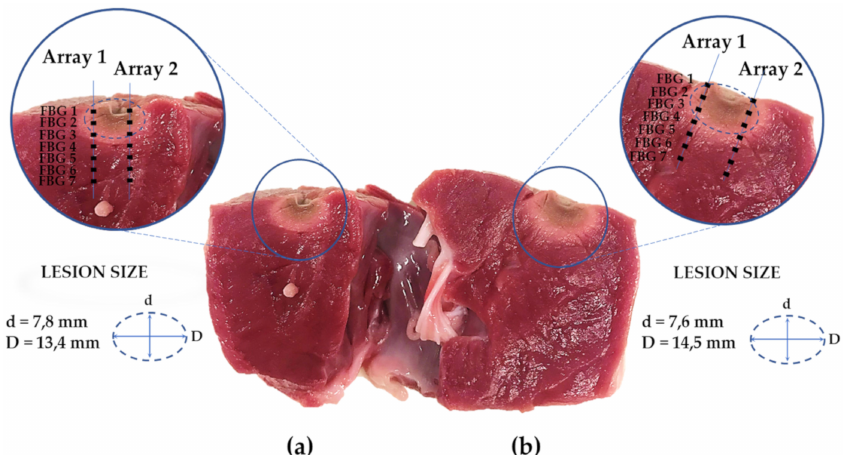
Figure 10. Picture of the two half-sections of the treated tissues sliced in correspondence to the lesions and focused on the positioning of the sensors within the specimens: ( a ) section of myocardium subjected to RFA with power setting of 50 W (Trial 1) with a zoom-in on Lesion 1; ( b ) section of myocardium subjected to RFA with power setting of 60 W (Trial 2) with a zoom-in on Lesion